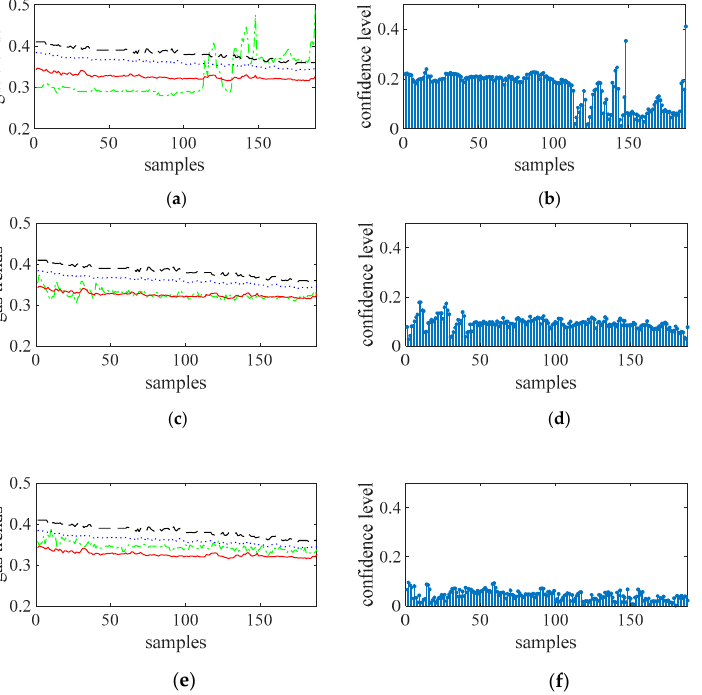
Figure 9. The measured values of sensors 4 to 6 and their confidence level. ( a ) gas sensor 4, ( b ) confidence level of gas sensor 4, ( c ) gas sensor 5, ( d ) confidence level of gas sensor 5, ( e ) gas sensor 6, ( f ) confidence level of gas sensor 6.